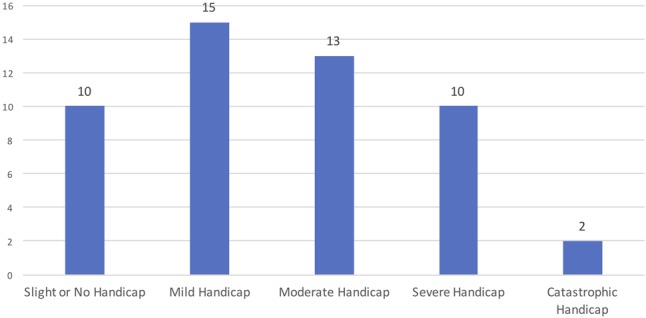
Distribution of the individuals according to THI.